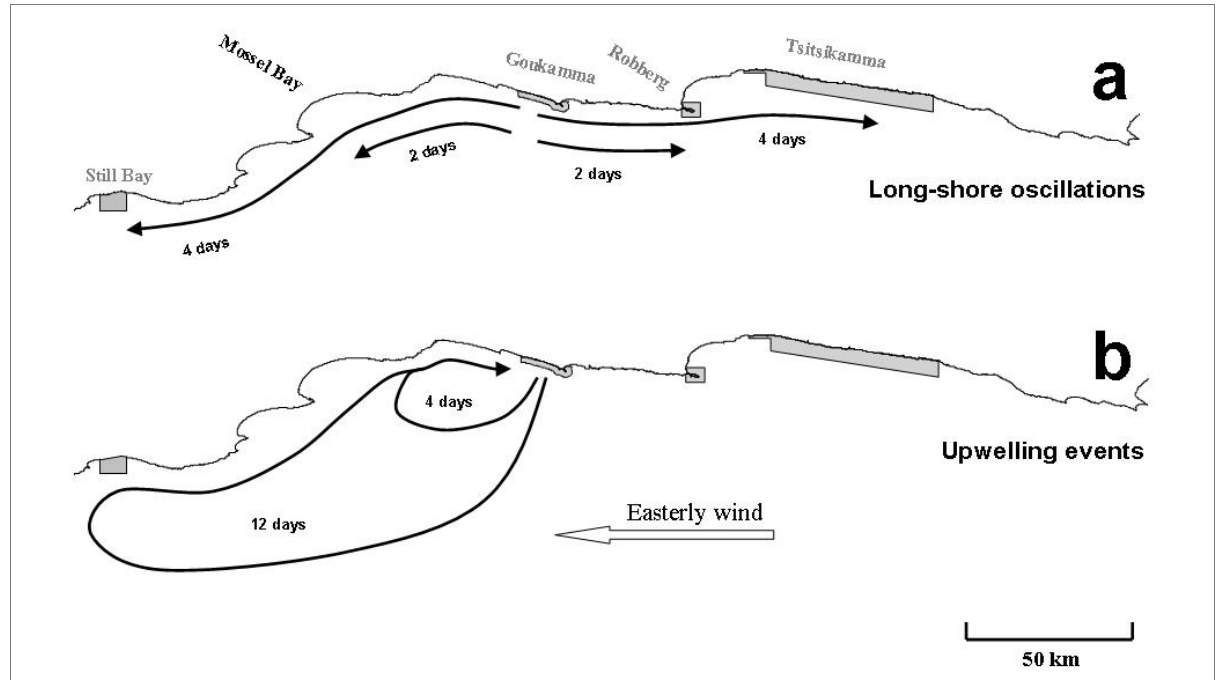
Figure 4: Projected distances of larval dispersal from the Goukamma marine protected area (MPA) into surrounding areas based on current patterns suggested by Tilney et al. 80 and Attwood et al. 81 and mean current velocities measured in the MPA. Arrows indicate potential larval dispersal (a) during long-shore oscillations with periods of 2 to 4 days and (b) upwelling events caused by strong easterly winds lasting for periods between 4 and 12 days. Shaded areas show the positions of